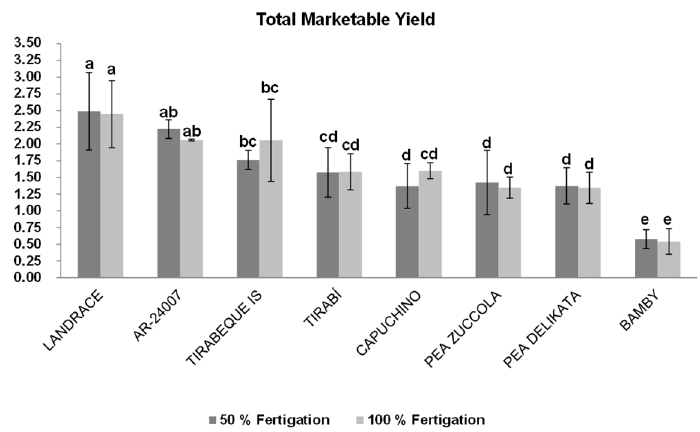
Figure 4. Total marketable yield (kg m − 2 ) of the different varieties of mangetout under different fertigation treatments (T50 and T100). Bars with different lowercase letters were significantly different at p < 0.05 (Tukey’s multiple range test).